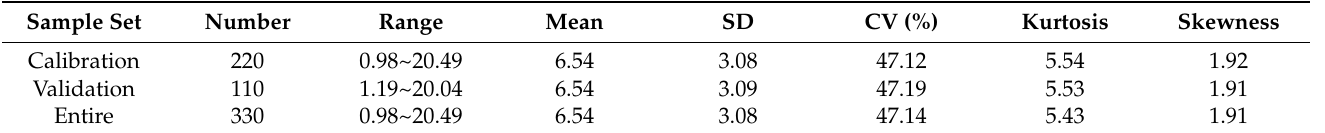
Table 1. Descriptive statistics of SOC (g kg − 1 ).